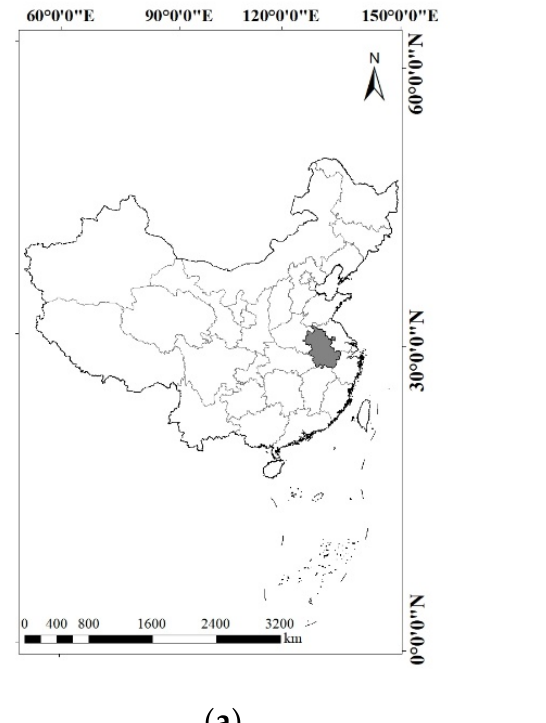
Figure 1. The map of the study area. ( a ) The gray province denotes where the study area is located. ( b ) The red rectangle represents the study area within the province.